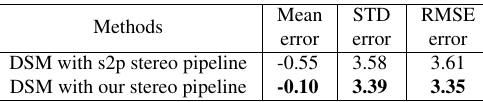
Table 5. Evaluation of our stereo matching pipeline (MCNN with 3SGM and labels from ARNN) against state of the art method (s2p) on London (UK).